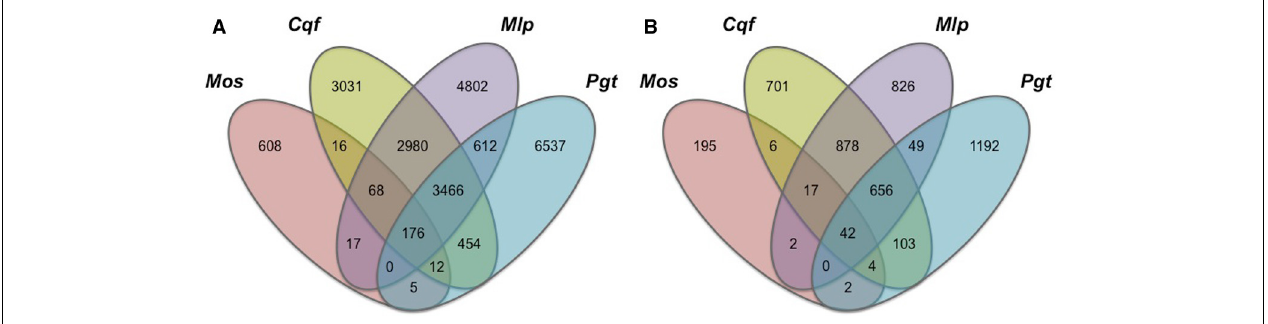
FIGURE 2 | Conserved proteins and families within only four Pucciniomycete pathogen genomes are mostly species-specific. Gene family (OrthoMCL) conservation within Pucciniomycete pathogens; Mixia osmundae (Mos), Cronartium quercuum f.sp. fusiforme (Cqf), Melampsora